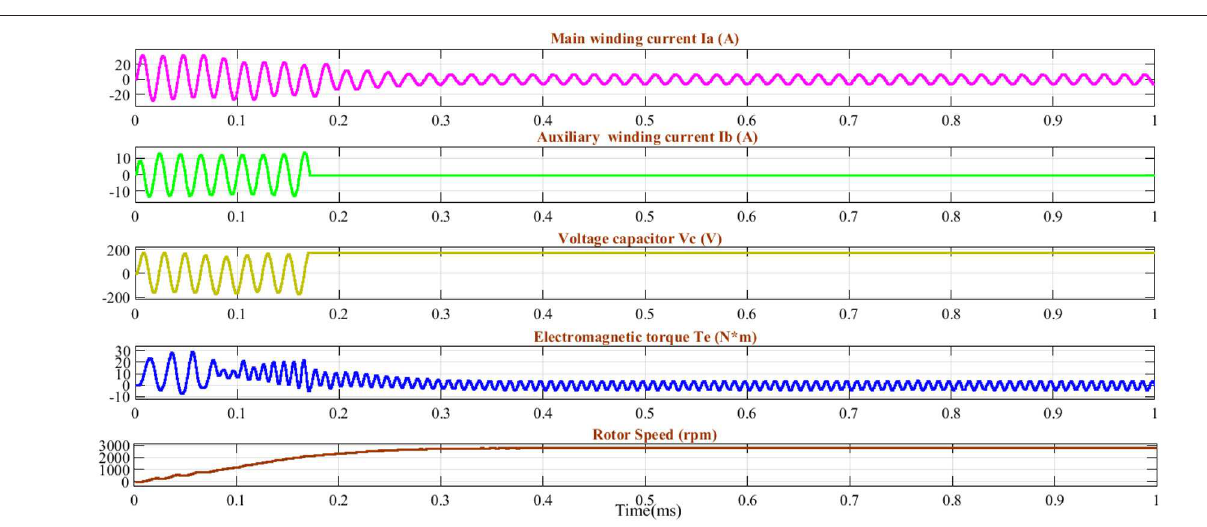
Frontiers in Energy Research |